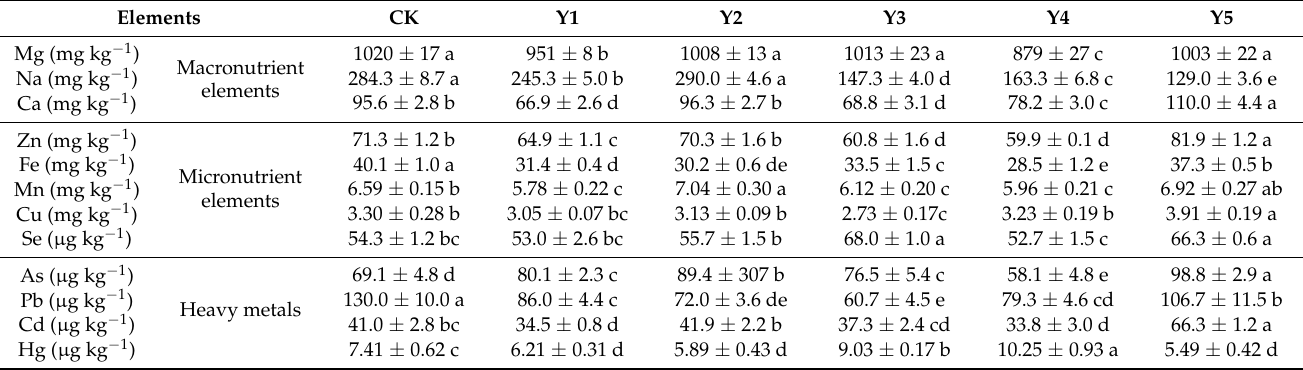
Table 6. Element content in Pleurotus eryngii when grown on different substrates # (mean ± SD, n =